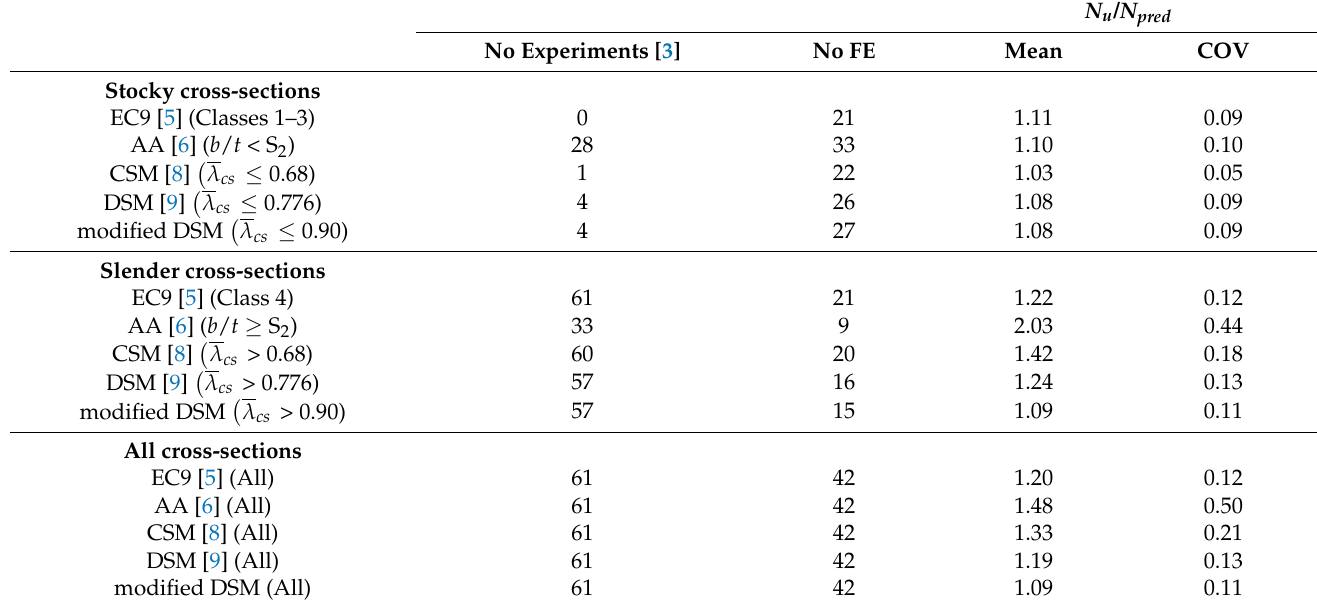
Table 5. Comparison of experimental [3] and FE results with design strength predictions.